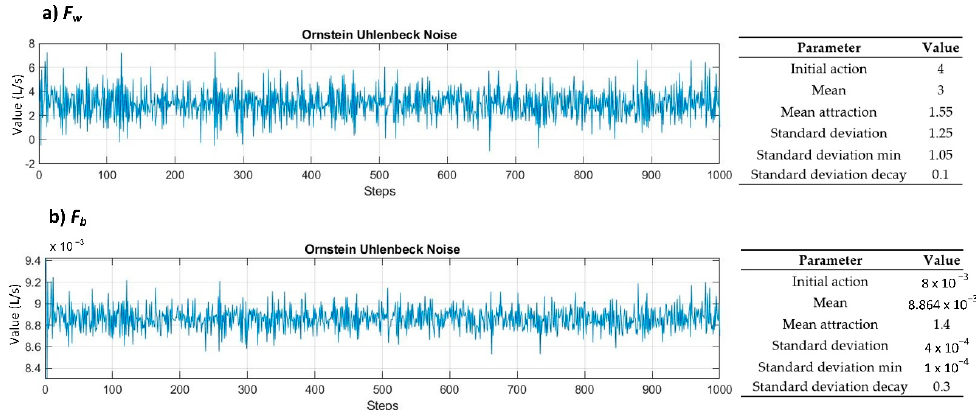
Figure 10. Simple flow diagrams of the RL training step for ( a ) liquid level control and ( b ) pH con- trol.